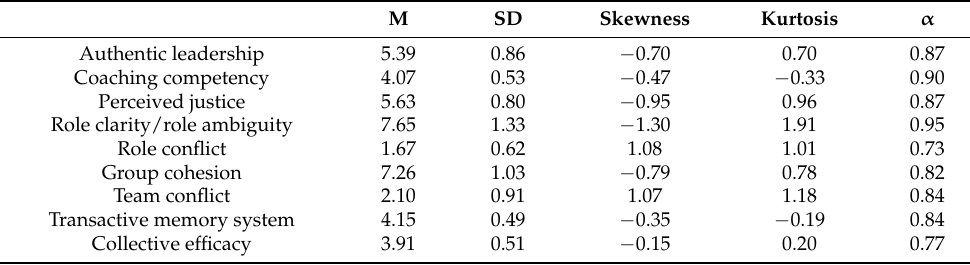
Table 1. Descriptive statistics, normality, and internal